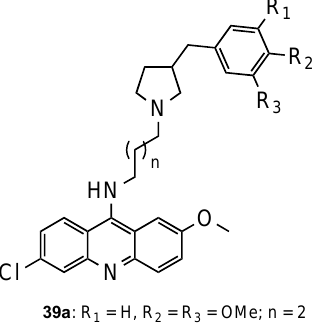
Figure 25. Most active compound 39a developed by Pandey and co-workers [55]. Recently, Dana et al. [56] focused their work on ciprofloxacin – acridine hybrids. Ciprofloxacin (CFX) is a second-generation fluoroquinolone-based antibiotic, known to be active against the in vitro culture of Pf [57,58]. In this work, the authors functionalized CFX in the N -terminal of the piperazine moiety with acridine scaffold. Hybrid 40 (Figure 26) was tested for its in vitro antimalarial activity against the CQS 3D7 strain of Pf . Alt- hough the activity of 40 was improved in comparison to that of CFX, it was not better than the reference CQ (3D7: IC 50 ( 40 ) = 359.40 nM, IC 50 (CFX) = 45350.0 nM, IC 50 (CQ) = 12.56 nM). However, it is noteworthy that compound 40 did not show any hemolysis of infected RBCs or uninfected RBCs at their highest tested concentrations (10 – 45 µM), which may suggest minimal toxic effects in vivo [56]. Figure 26. CFX–acridine hybrid 40 developed by Dana and co-workers [56]. Blackie et al. [59] established the role of ferrocenyl moiety in the antiplasmodial activity of ferroquine, another import scaffold in antimalarial derivatives [60]. The authors concluded that ferrocenyl fragment serves simply as a hydrophobic spacer group. Next, they synthesized compound 41 (Figure 27) and tested them against CQS 3D7 and CQR K1 strains of Pf . It is noteworthy that hybrid 41 showed potent antimalarial activity (ED 50 = 1 and 8 nM against CQS 3D7 and CQR K1 Pf strains, respectively), comparatively to CQ (ED 50 = 8.52 and 290 nM against CQS 3D7 and CQR K1 Pf strains, respectively) [59].